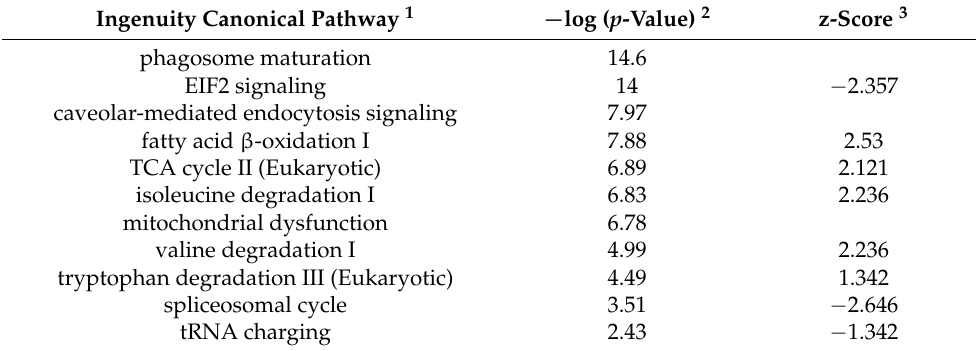
Table 5. Selected canonical pathways altered in HF-MSS, based on Ingenuity Pathway Analysis. Ingenuity Canonical Pathway